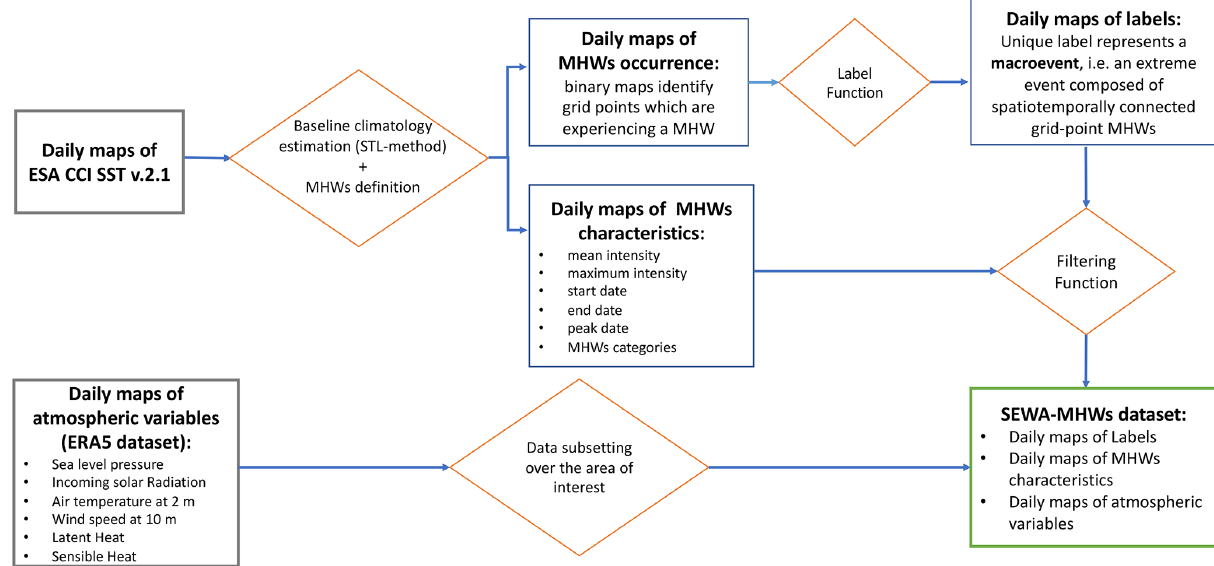
Figure 2. Flow diagram of the data processing to generate the SEWA-MHW dataset. Gray squares indicate data input. Blue squares indicate intermediate or output data. The green square indicates the final output (SEWA-MHW dataset). Orange rhombuses indicate the function/pro- cess applied.